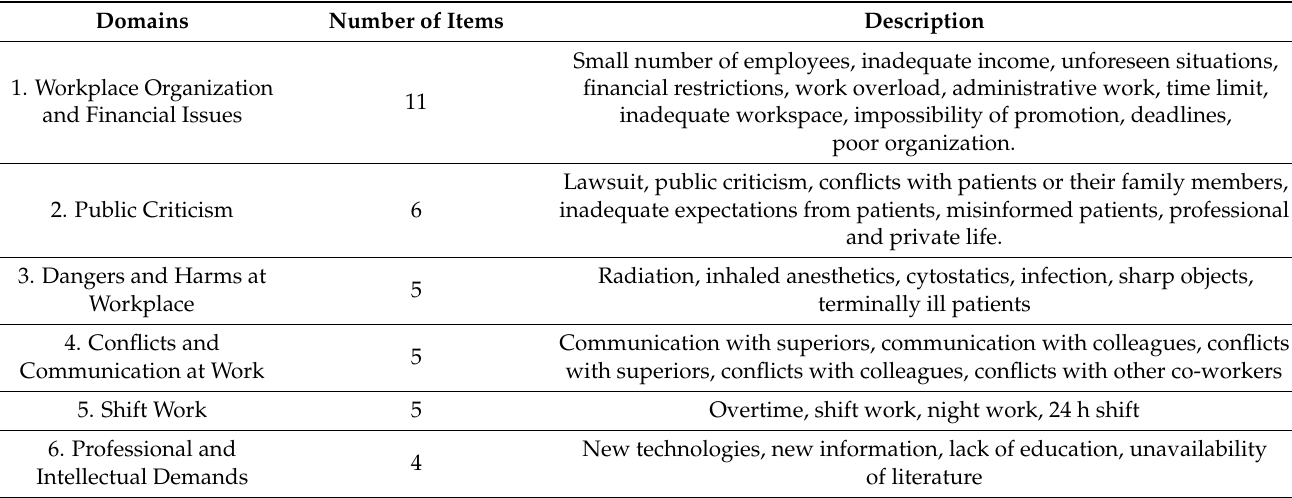
Table 1. Description of domains and items of the Questionnaire on Workplace Stressors for Hospi- tal